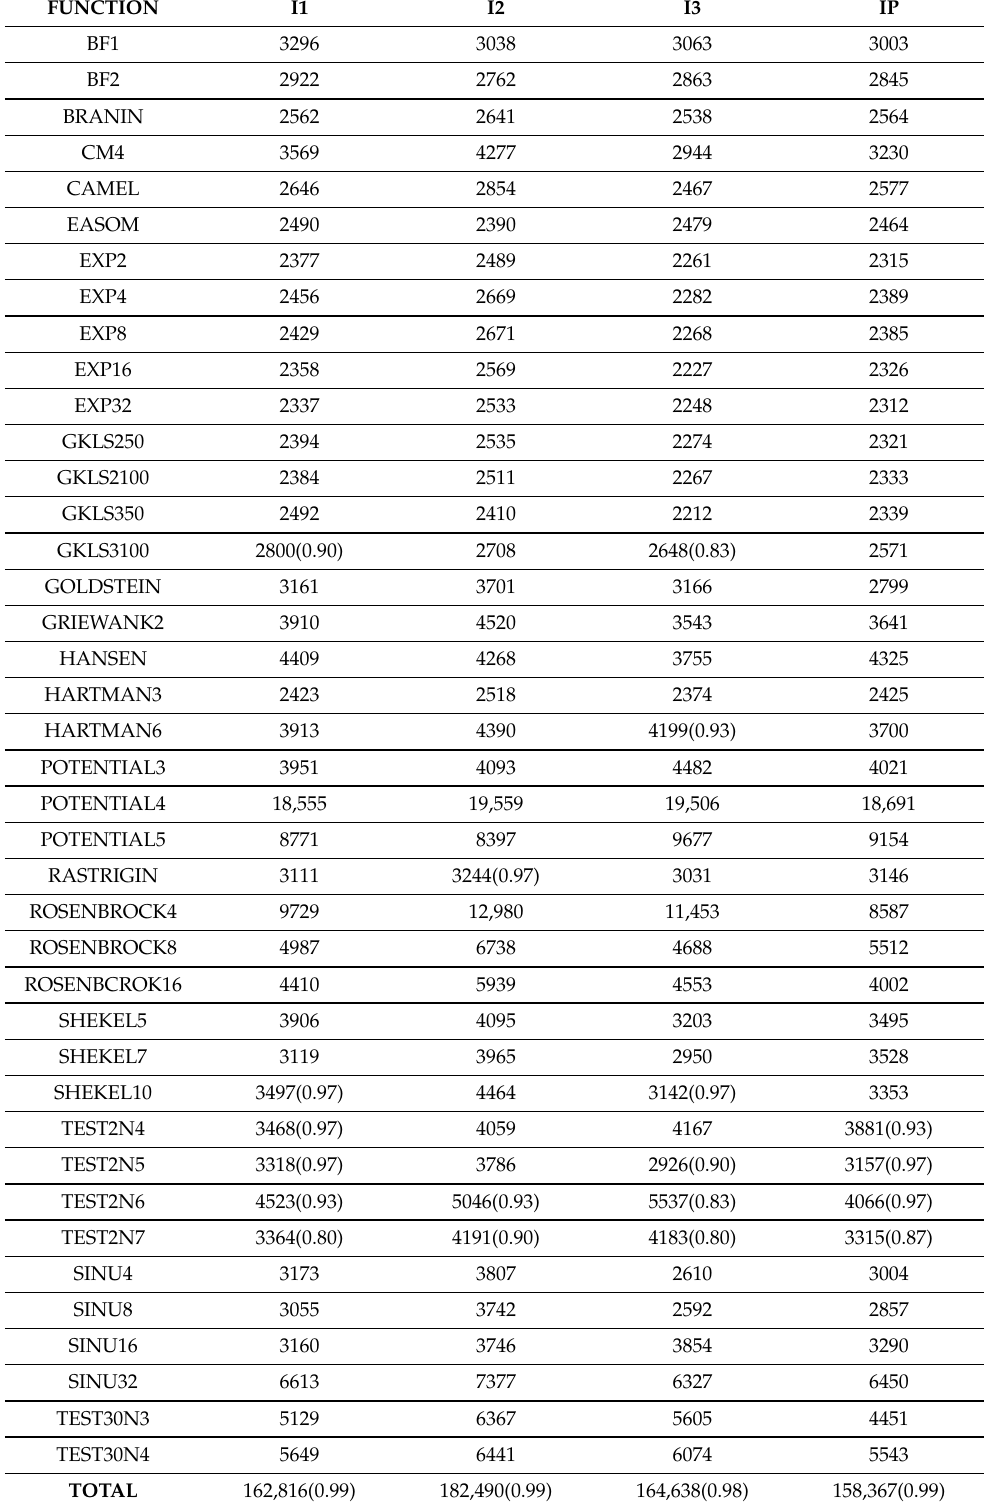
Table 5. Experiments with the double box stopping rule with the gradient check